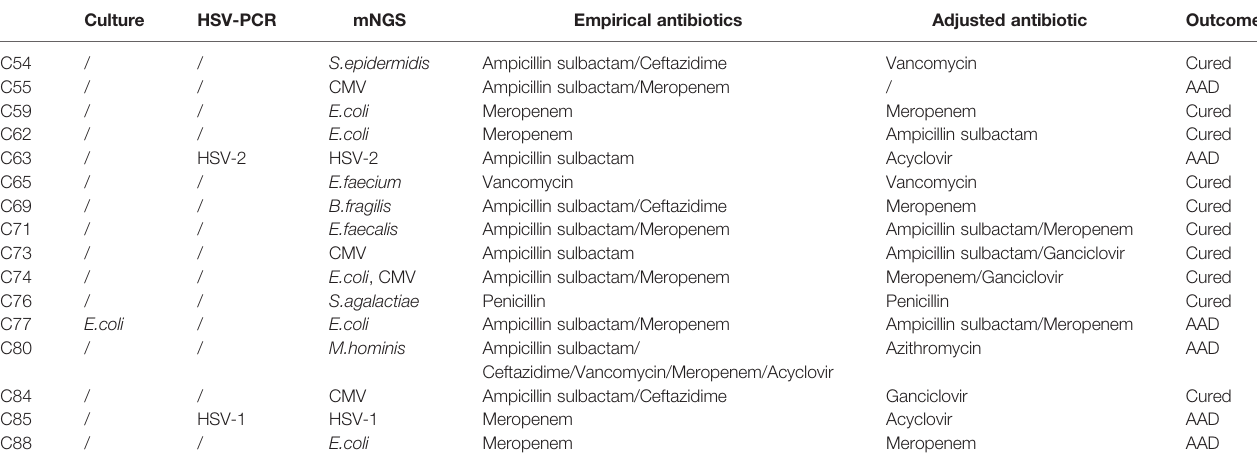
TABLE 3 | Clinical management of 16 patients based on mNGS*.